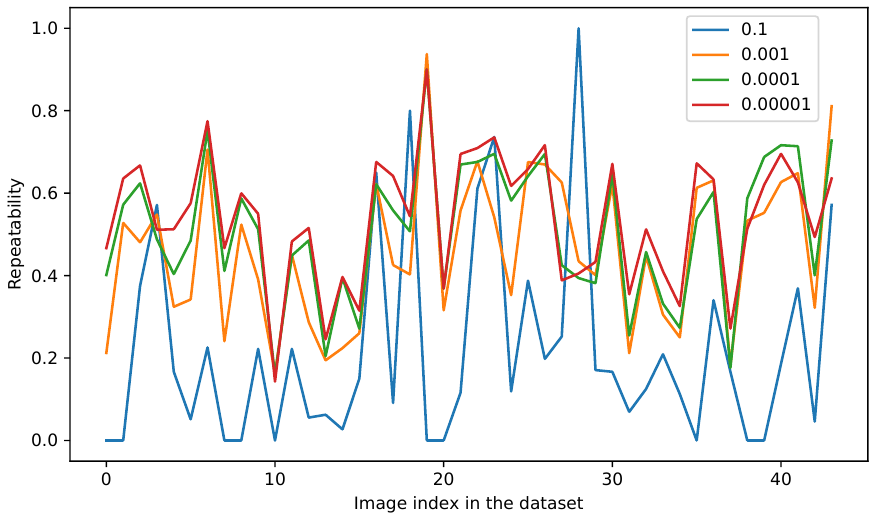
Figure 5. Detector parameters tuning: repeatability for several “quality levels” according to each image pair in the dataset.